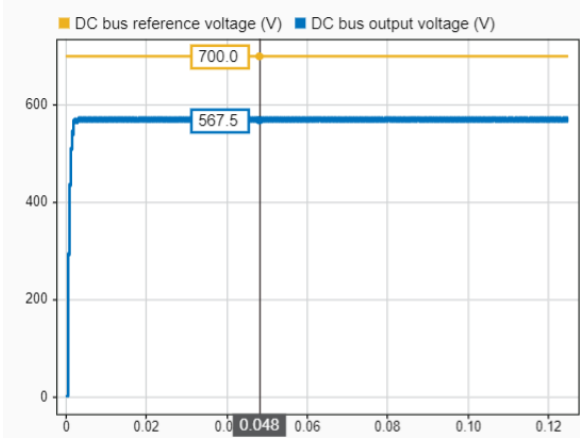
Figure 13. Output voltage using MPC under optimal EPS operation.